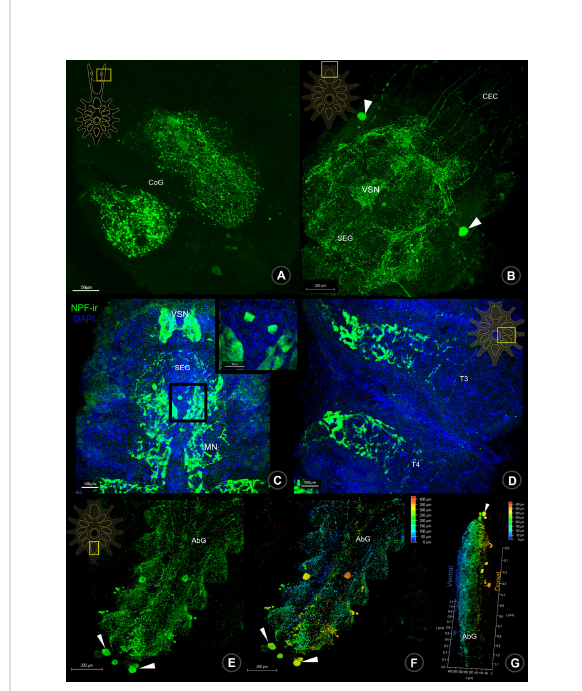
FIGURE 3 Wholemount immuno fl uorescence photographs of Macro -NPF- ir in the ventral nerve cord. The NPF-ir detection presented in CoG (A) , nerve fi bers of CEC, neurons (arrows) and neuropil of SEG (B, C) , thoracic neuropils (D) , neurons (arrows) and neuropils of AbG (E) . The ventral (F) and lateral views (G) of depth coding photographs of NPF-ir shown in AbG. CoG , commissural ganglion; CEC , circumesophageal connection; SEG , subesophageal ganglion; T , thoracic ganglion; AbG , abdominal